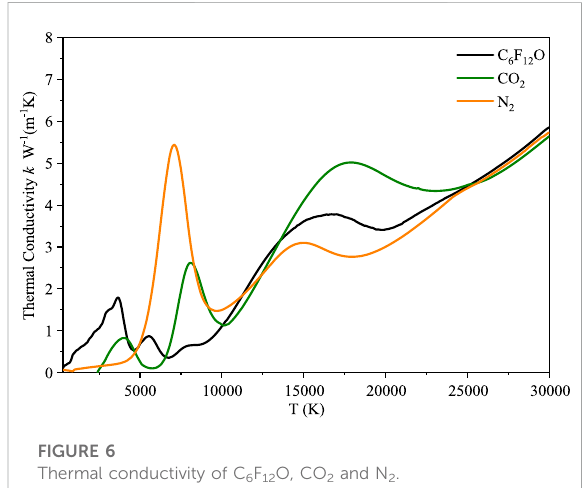
FIGURE 6 Thermal conductivity of C 6 F 12 O, CO 2 and N 2